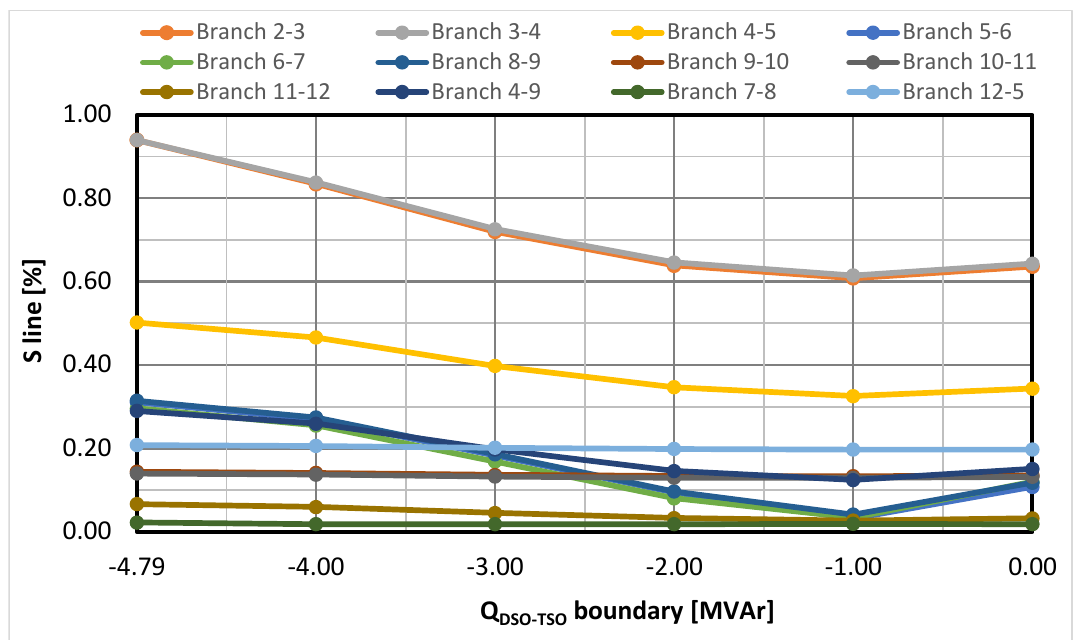
Figure 9. Nodes voltages for increasing TSO Q inductive needs.